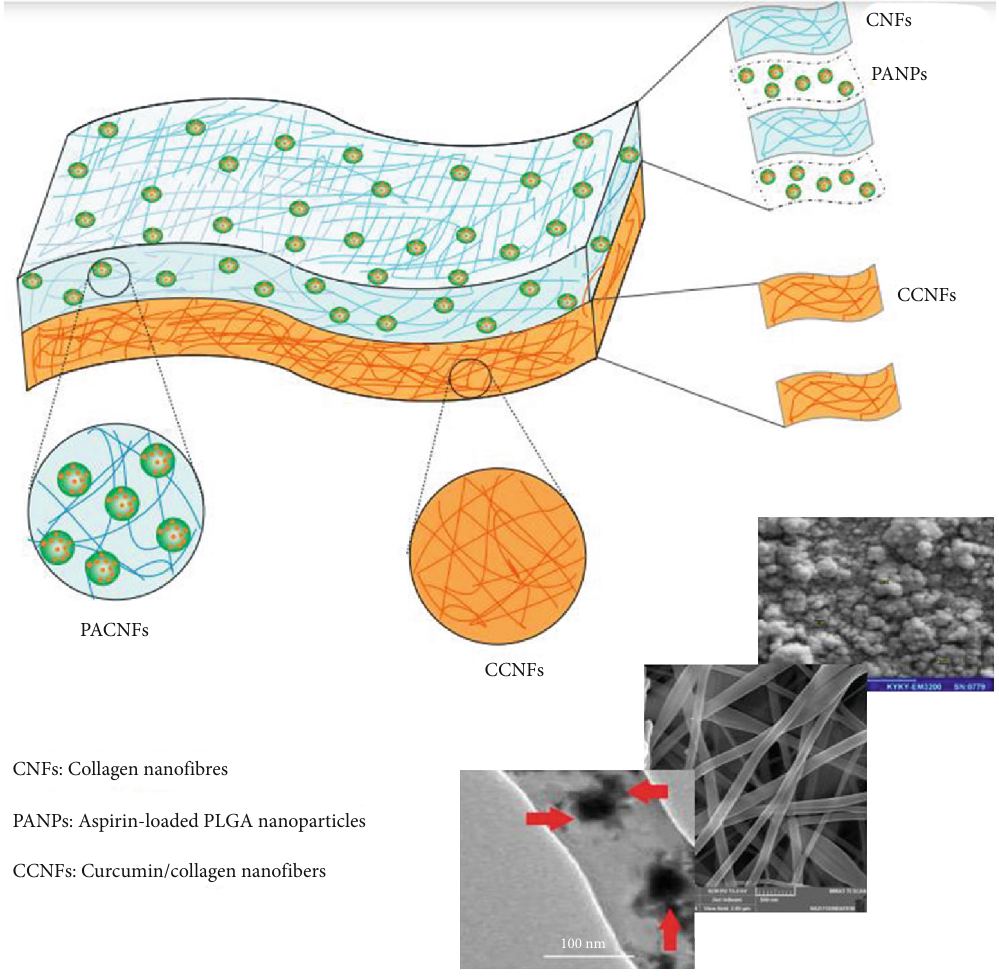
Figure 1: Combination of curcumin and aspirin in asymmetric multifunctional GBR nano fi brous sca ff old.